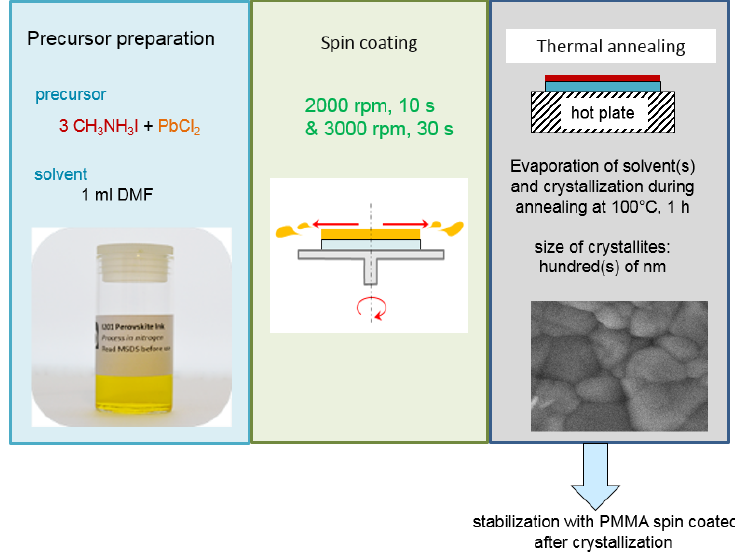
Figure 1. CH 3 NH 3 PbI 3 film preparation followed by PMMA capping layer.